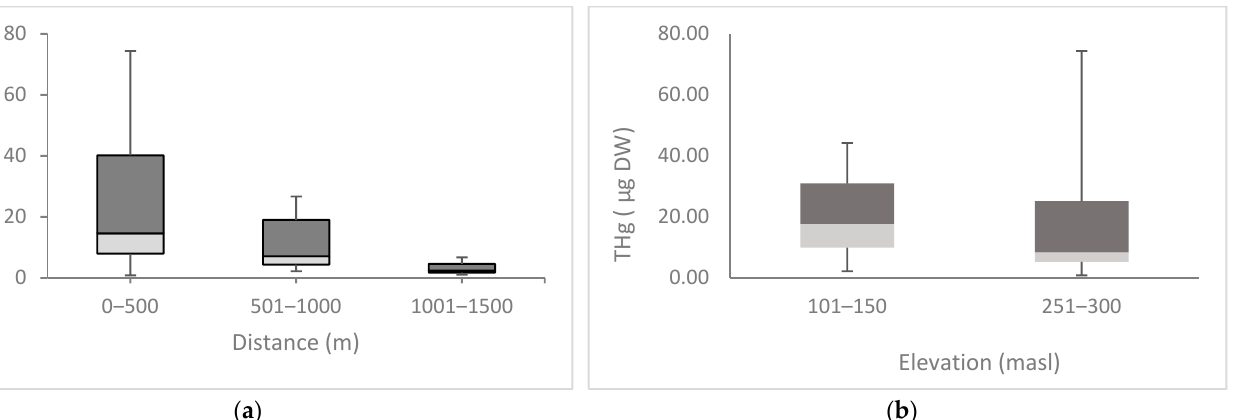
( b ) Figure 4. Distribution of the MPTS plant correlations: ( a ) Distribution of the distribution patterns on dis- tance and THg variables; ( b ) Distribution of the distribution pattern on the variables of height and THg. The T. indica plants showed the same behaviors. The THg of T. indica 1 measured at a distance of 240 m was greater than that observed at a distance of 418 m (Figure 4a). This supports the correlation value of the two variables, which are negative and have a mod- erate interpretation. A decrease was seen at a distance of 1000 m, but some plants had a fairly high THg above 500 m. The difference in THg in the barks of MPTS plants is mostly caused by factors such as skin roughness, which affects the absorption of mercury, as it